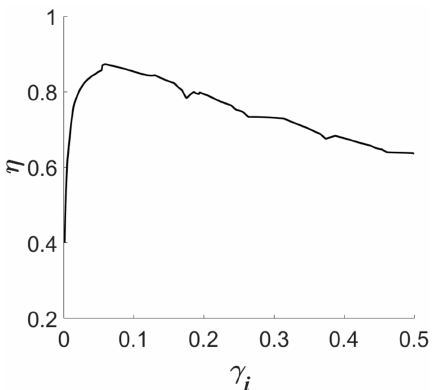
Figure 14. The variation of efficiency of the five NESs with damping.